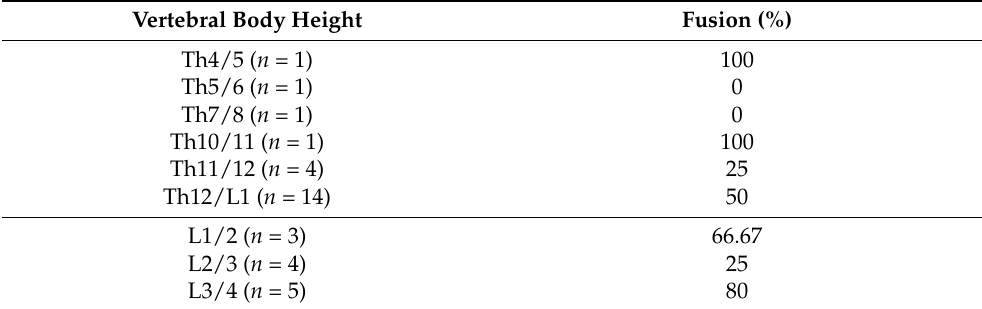
Table 3. Bony fusion of autologous pelvic bone graft and different vertebral body